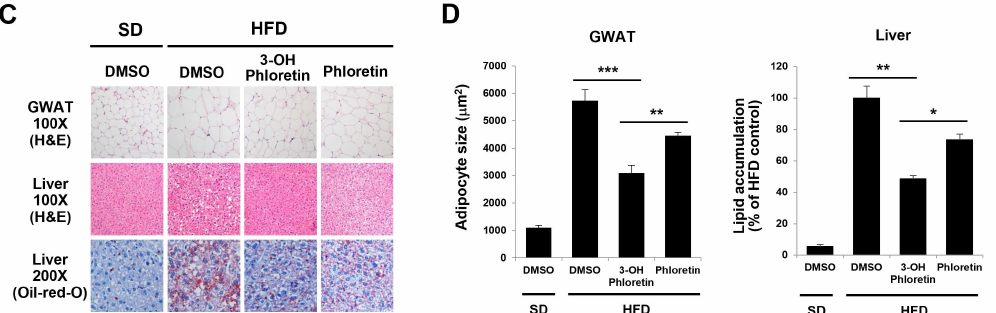
Figure 2. 3-OH phloretin showed higher inhibitory effects on HFD-induced increases in fat mass, WAT weight, adipocyte size, and lipid accumulation than phloretin. ( A ) Representative images of the GWAT and RWAT ( n = 5/each group). ( B ) Weights of the GWAT and RWAT are represented in bar graphs. ( C ) The GWAT and liver tissue sections were stained with H&E or Oil-Red-O and examined under a light microscope at × 100 or × 200 magnification. ( D ) The cross-sectional diameter of adipocytes was calculated using ImageJ and represented as bar graphs. The data represent eight independent experiments with similar results. The data shown represent eight independent experiments, and the error bars indicate the mean ± SEM (* p < 0.05, ** p < 0.01, *** p <